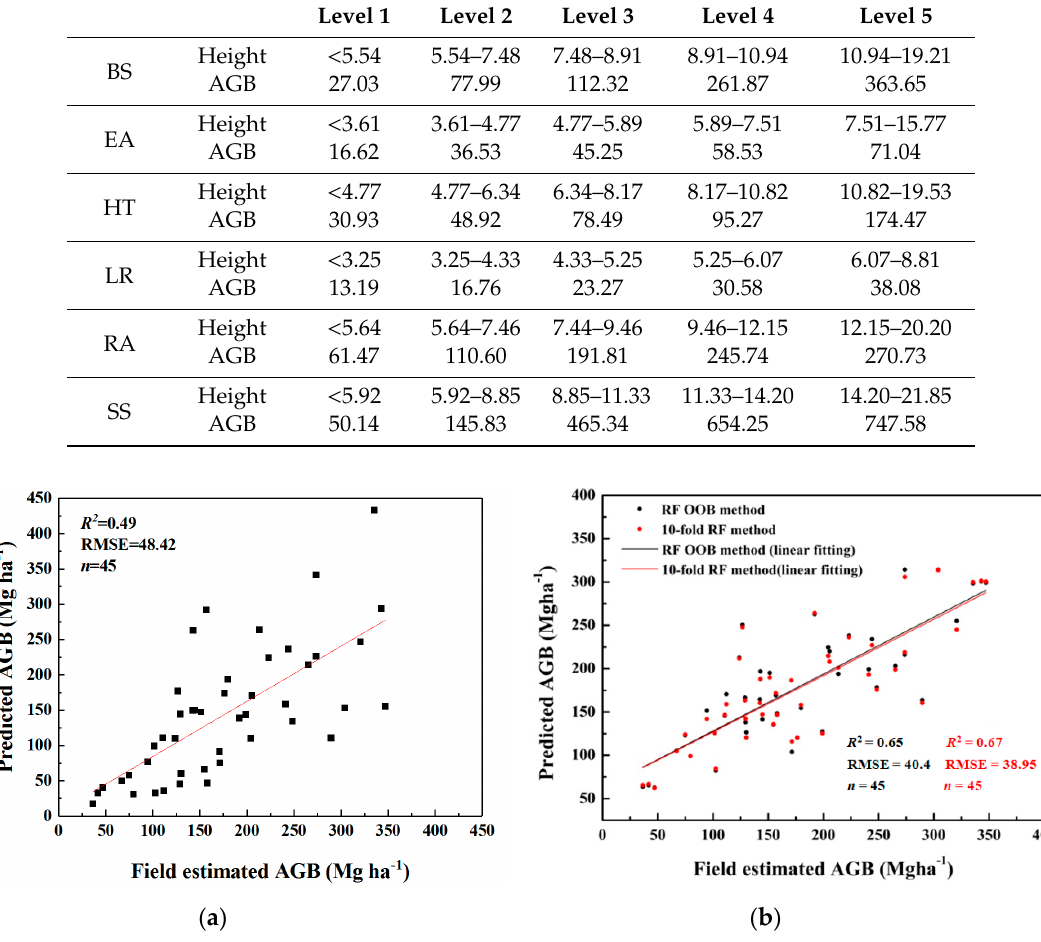
Figure 5. Accuracy comparison of AGB between the field estimated and predicted values. ( a ): Case 1, individual tree-based inference method. ( b ): Case 2, grid-based RF model